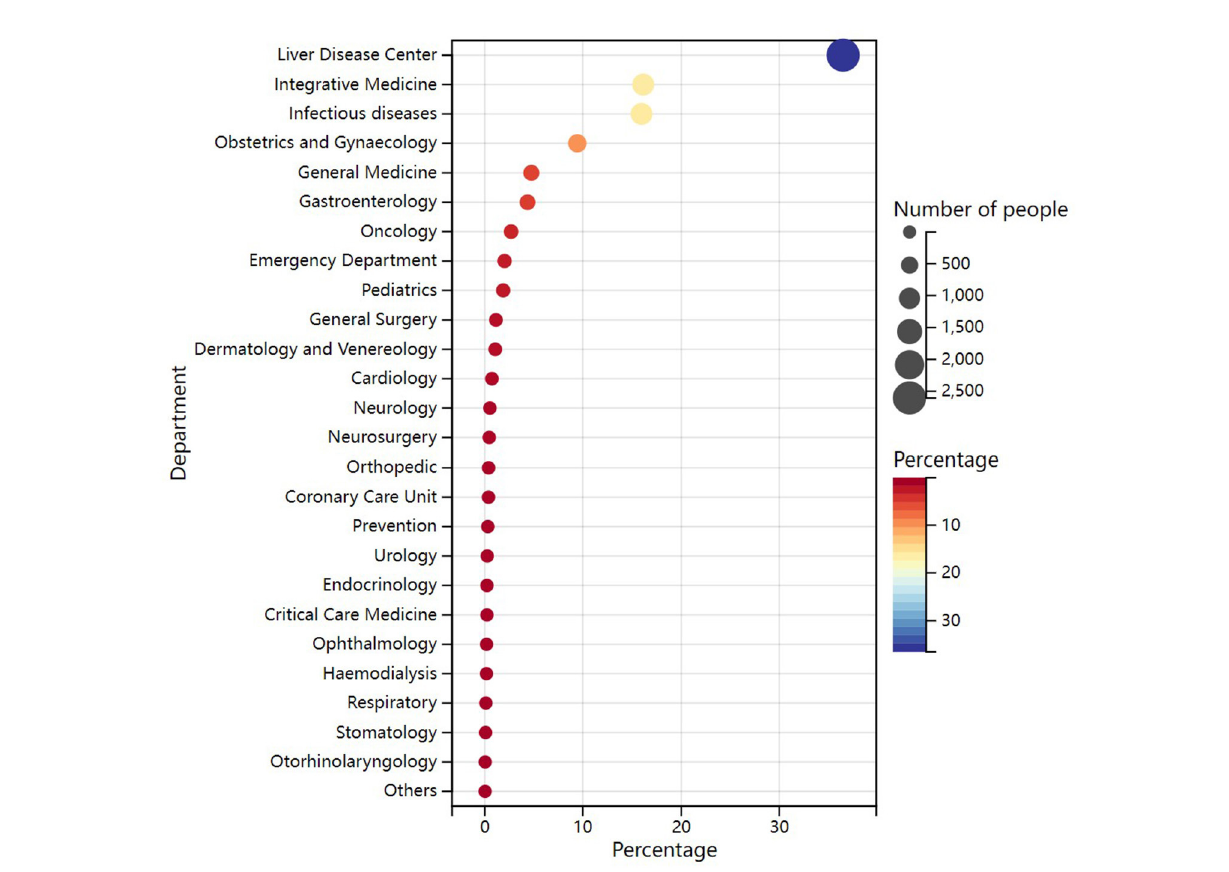
FIGURE2 Departmental origin of HCV antibody positive patients. The color of the circle represents the percentage of patients. The size of the circle represents the number of patients, with larger circles indicating a larger number of patients.